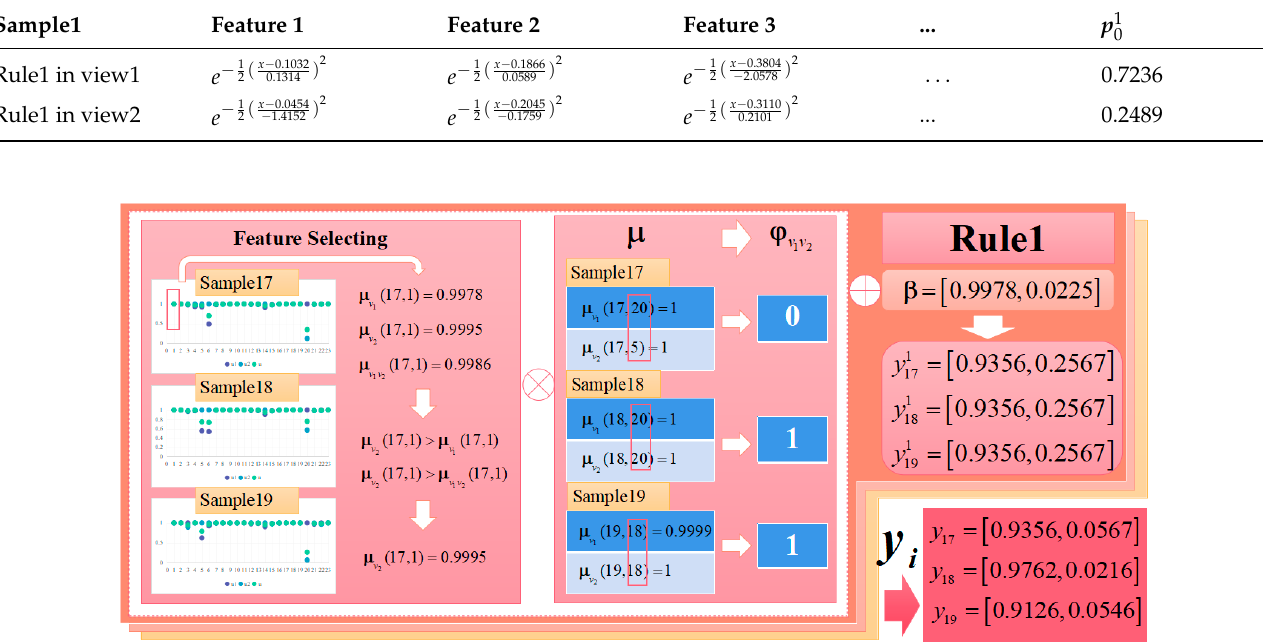
Figure 10. Antecedent and consequent parameters and the Gaussian membership function.